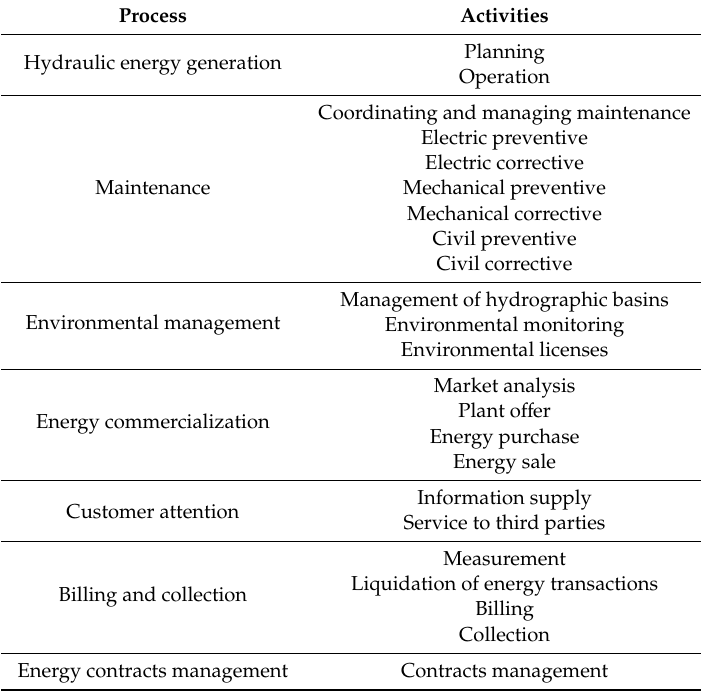
Table 2. Processes and activities of the hydraulic generation